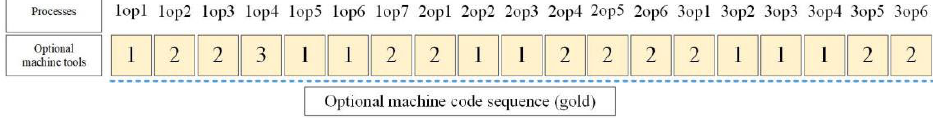
Figure 4. Encoding sequence of machine tool layer.